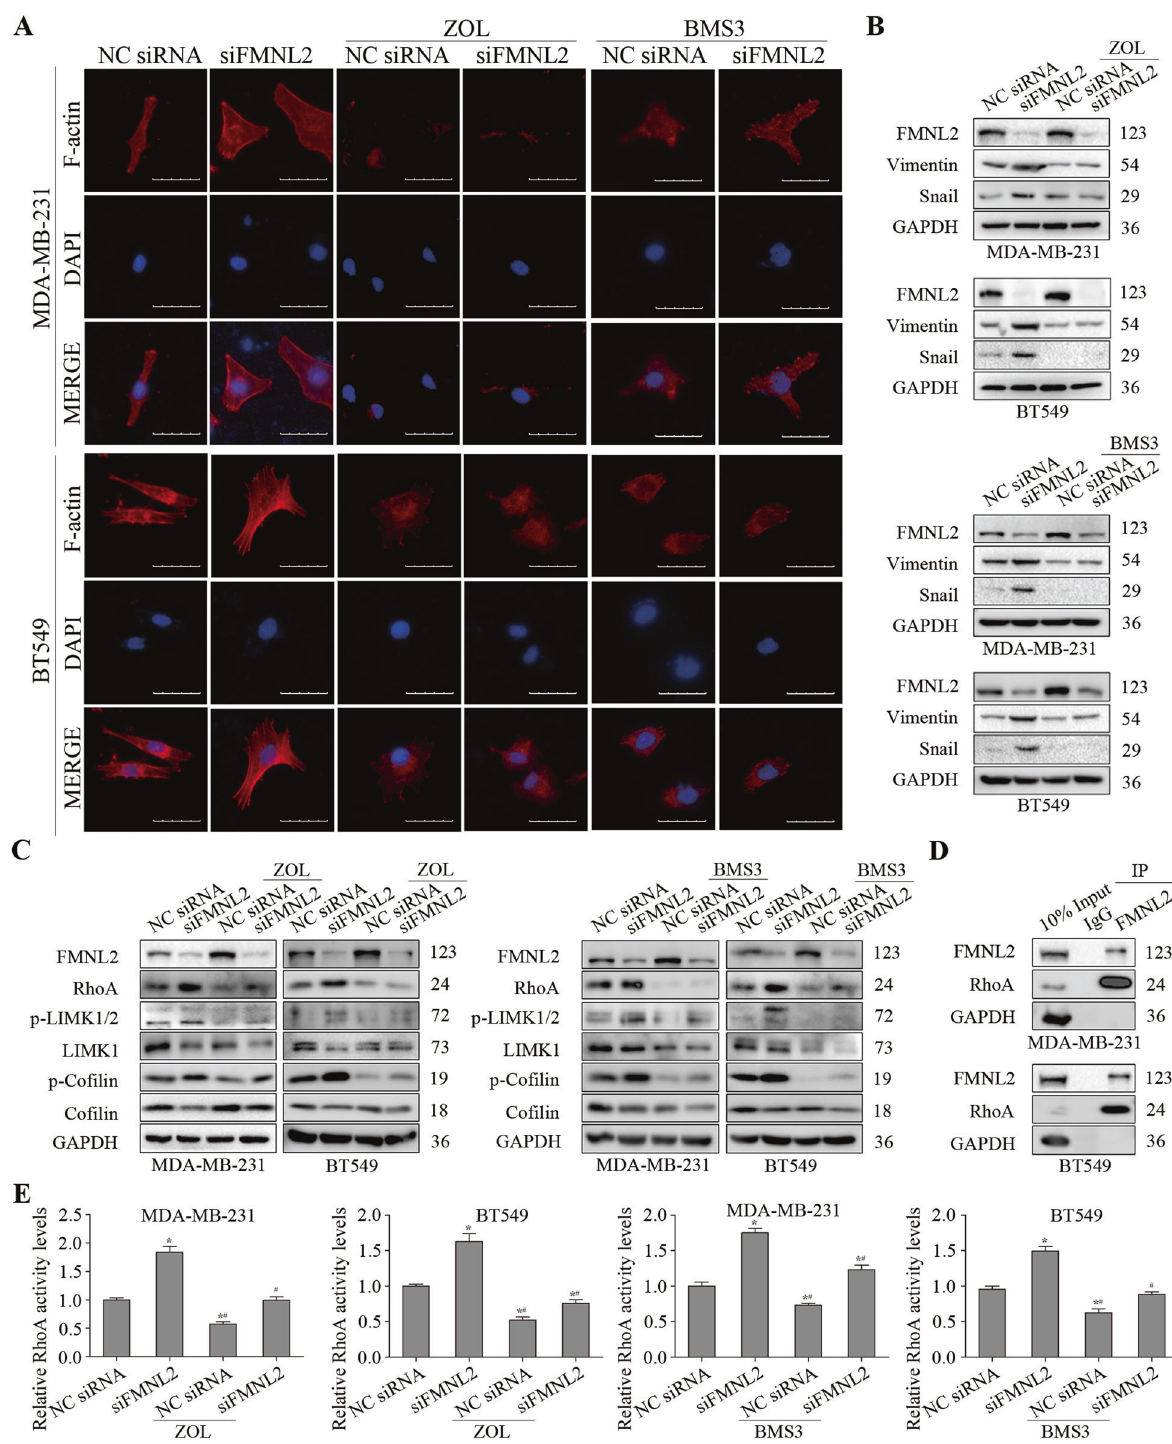
Fig. 3 Effects of Rho and LIMK inhibition on cytoskeleton rearrangement and RhoA/LIMK/Co fi lin pathway in FMNL2-silencing breast cancer cells. After transfection, MDA-MB-231 and BT549 cells were incubated with ZOL (100 or 70 μ M) or BMS3 (20 or 10 μ M) for 24 h, respectively, and then performed for indicated assays. A Representative fl uorescent images of F-actin cytoskeleton were displayed. Scale bar, 50 μ m. B The levels of FMNL2, Vimentin and Snail were measured by western blotting. C The levels of RhoA/LIMK/Co fi lin-related molecules were examined by western blotting. D Co-IP analysis was used to determine the relationship between FMNL2 and RhoA. E The activity levels of RhoA were measured. * P < 0.05 versus NC siRNA group, # P < 0.05 versus siFMNL2 group.